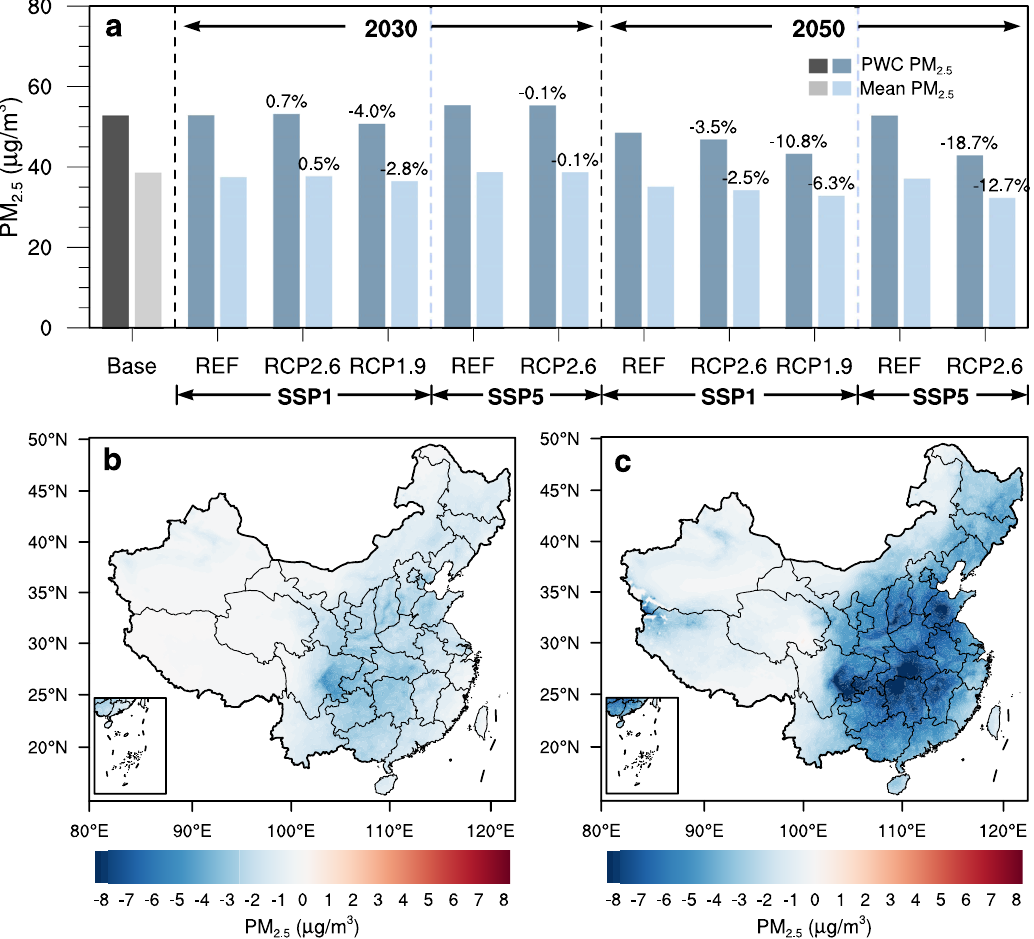
Fig. 4 Changes in PM 2.5 concentrations brought about by climate policies under various scenarios. a PWC-PM 2.5 and annual mean PM 2.5 concentrations under different scenarios in 2030 and 2050. Fractional changes (%) relative to the corresponding REF scenarios are noted; b , c Spatial distribution of PM 2.5 changes between SSP1_RCP1.9 and SSP1_REF in 2030 and 2050, respectively. Note that 2015 is chosen as the base year.